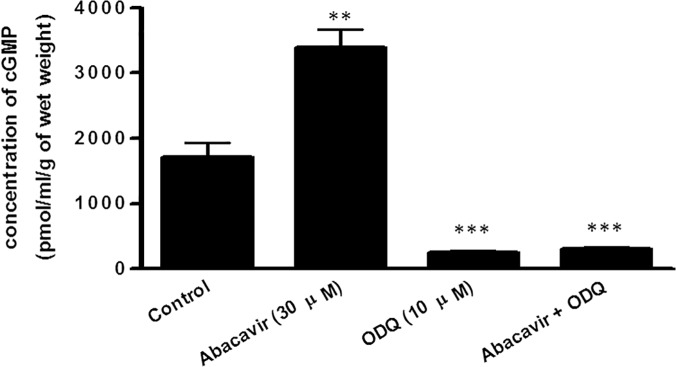
Effect of abacavir on the concentration of cGMP in rat basilar arteries.Rat basilar arteries were pretreated with or without ODQ (10 μM) for 30 min and then stimulated with or without abacavir (30 μM) for 20 min. Arteries not treated with ODQ and abacavir served as controls. cGMP content in the arteries was determined using an ELISA kit. Values are means ± S.E.M. of three sets of experiments and statistical comparisons were made using ANOVA. ** P<0.01 and *** P<0.005 compared with control.